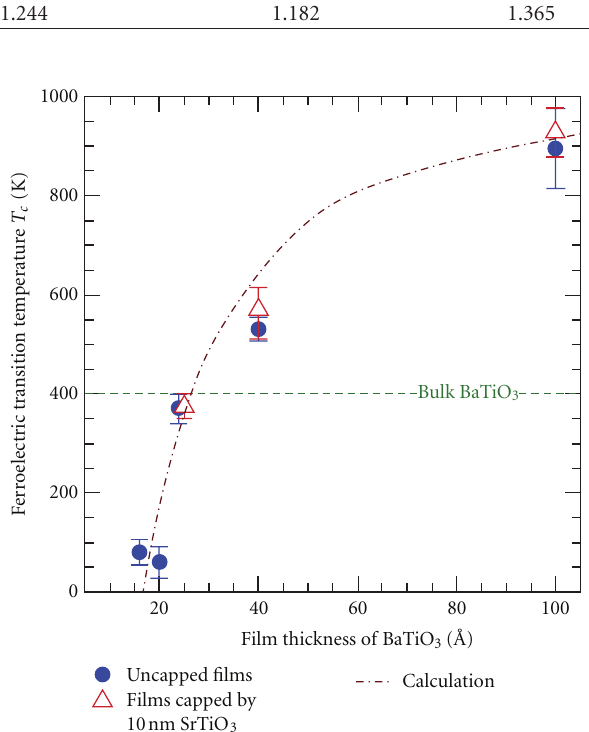
Figure 11: The plot of the ferroelectric phase transition temper- ature T c versus film thickness of BaTiO 3 films grown on SrTiO 3 substrates, observed by Raman scattering